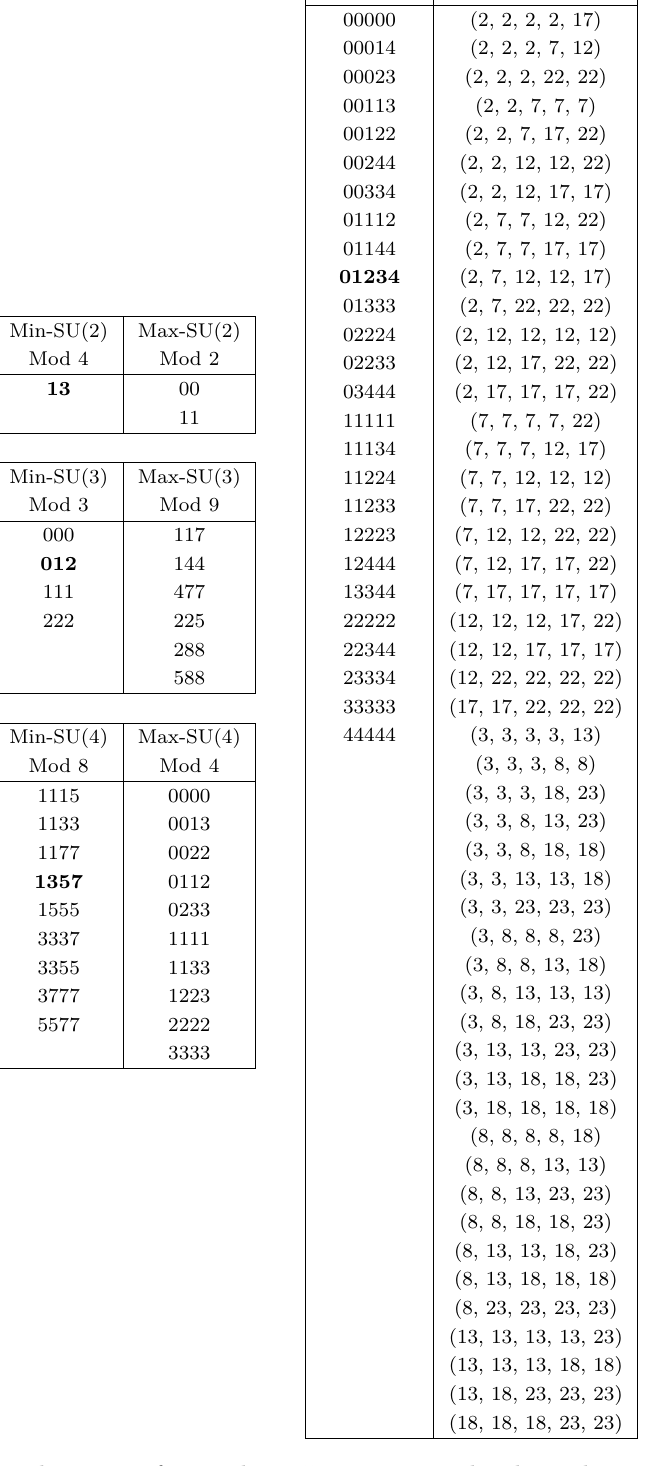
Table 1 . The min and max set for one-loop V